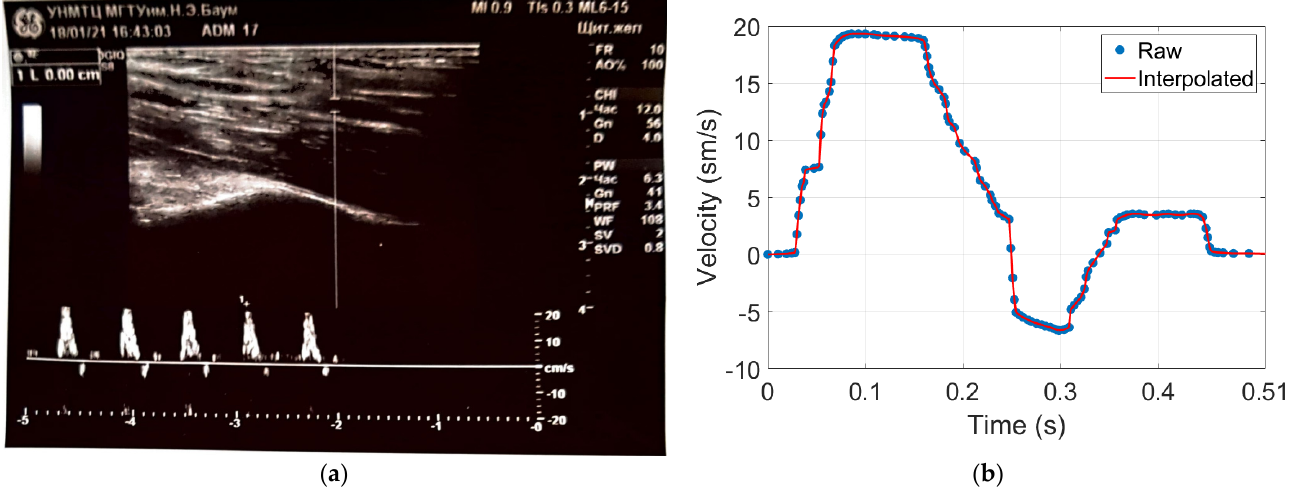
Figure 5. The obtained data using Doppler US: ( a ) brachial blood velocity assessment during 5 cardio cycles; ( b ) the averaged blood velocity curve.